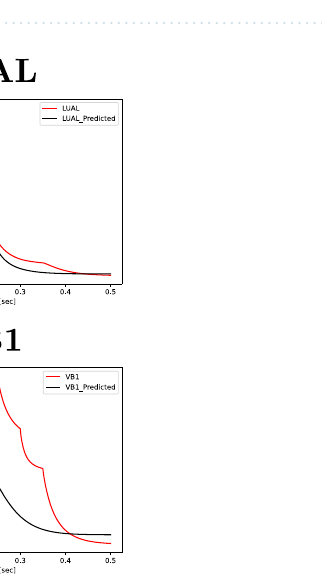
Figure 10. Experiment 3: realistic (red and blue) and predicted (green and black) sequences for DB1 and LUAL (1st and 3rd rows) and PVR and VB1 (2nd and 4th rows) for two sequences of the test set (one selected simulation out of ten).